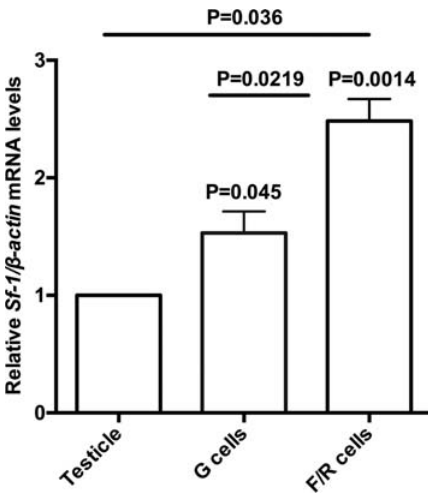
Figure 1. Quantitative reverse transcription PCR (qRT-PCR) analysis of relative Sf-1/ b -actin mRNA levels in testicular tissue, used as a normalizer, and in rat adrenal glomerulosa (G) and fasciculata/reticularis (F/R) primary cells. Data are reported as the means ± SD from three experiments. Statistical signi fi cance was assessed by paired t -tests and one-way ANOVA.